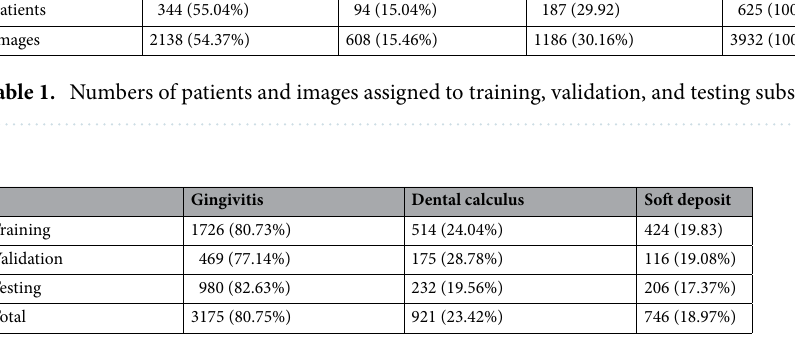
Table 2. Distribution of images with positive findings among training, validation, and testing subsets for each type of diagnosis. The data shows the numbers of images with positive findings, as well as their proportions within all the images of a